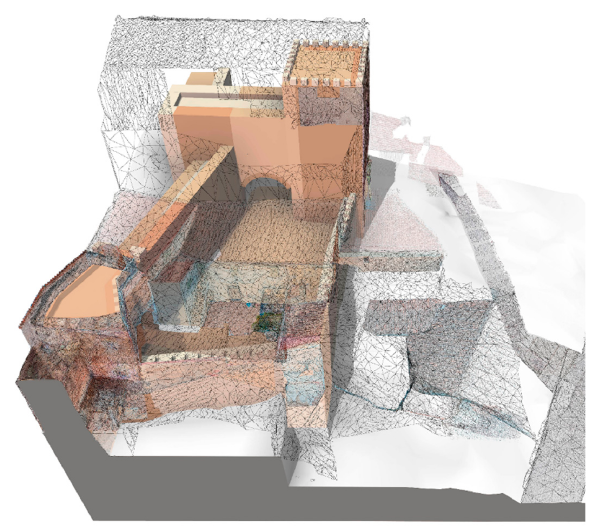
Figure 12. Modeling and digital documentation work. Concept of a possible bastion located between the Torre del Aire and the corrala to which our building allows access. The recreation is modeled in Revit, IFC format, from laser scanner shots that guarantee centimeter accuracy, which allows us to analyze reality.